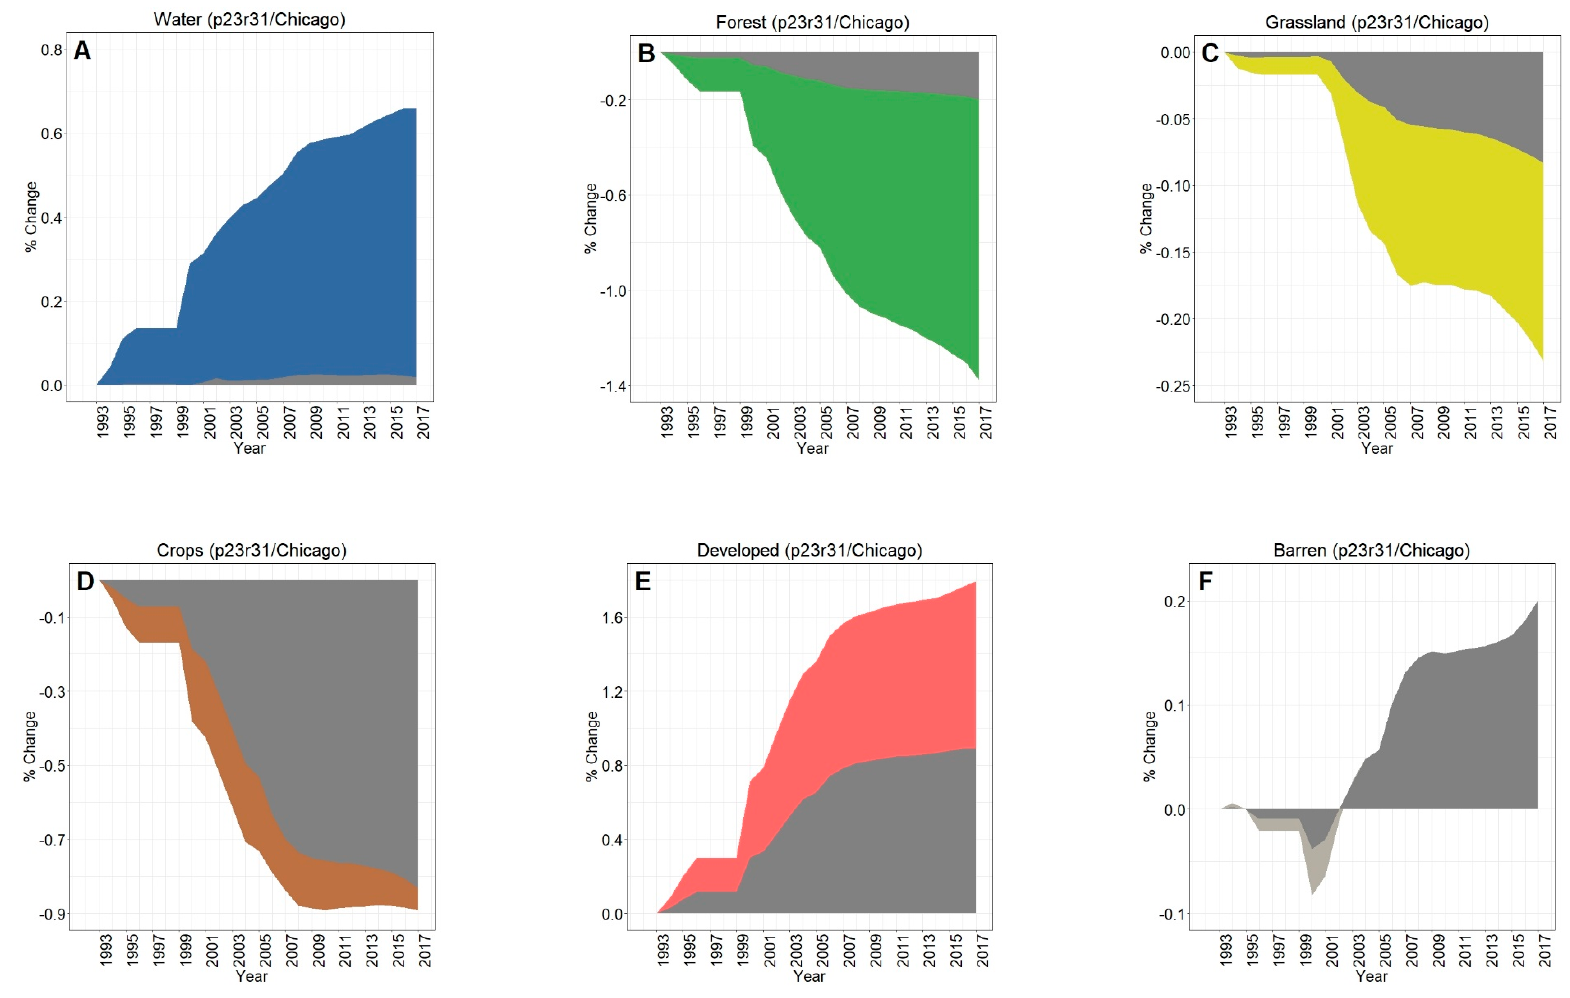
Figure 9. Contrasting LULC change in the areas buffering waters with the Chicago-area footprint-wide change for ( A ) water, ( B ) forest, ( C ) grassland, ( D ) crops, ( E ) developed, and ( F ) barren classes.